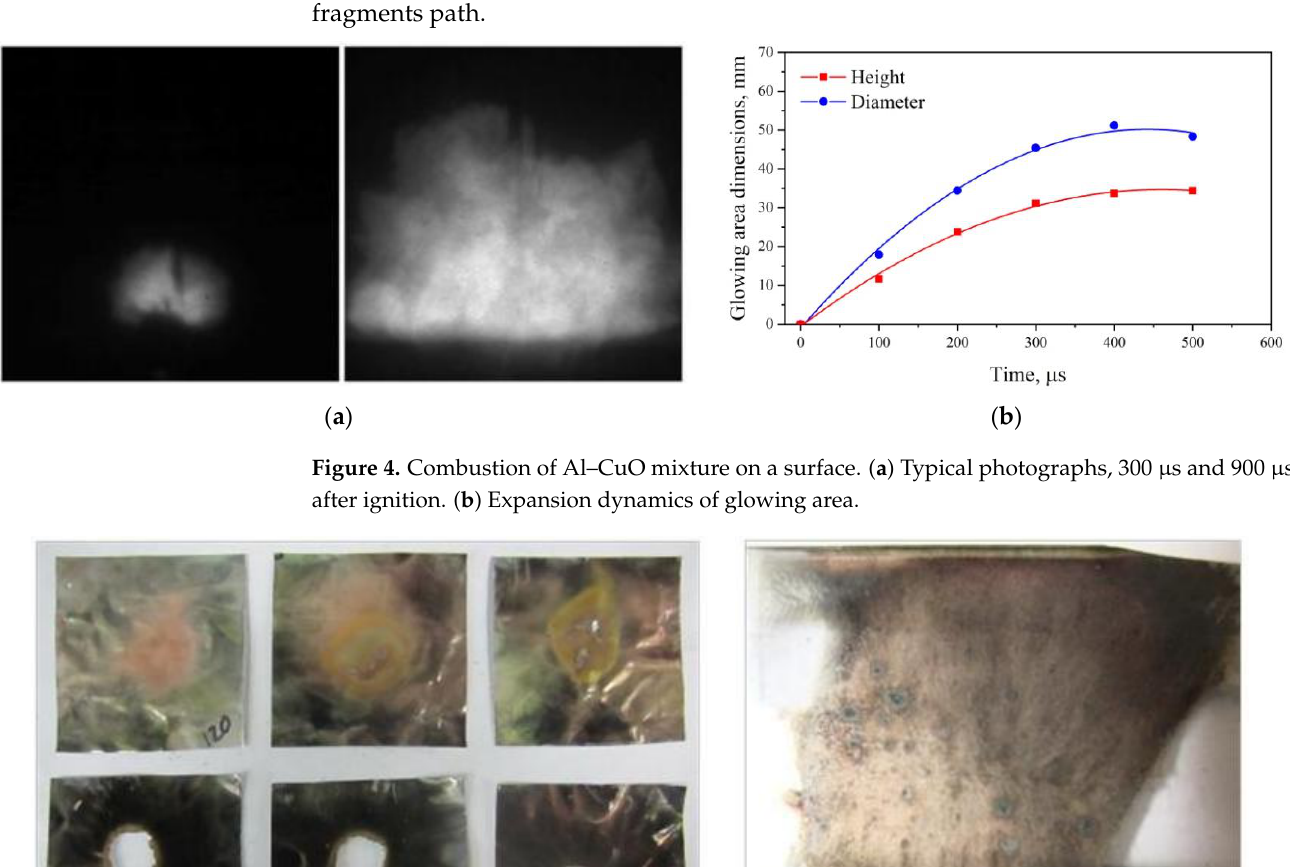
Figure 5. The photographic evidence of an impact of the frontal flow of combustion products. ( a ) The impact of mixture weighing 0.3 g on a 0.15 mm thick aluminium foil for distances of 120, 90, 60, 52, 45 and 30 mm (from left to right and from top to bottom), respectively. ( b ) Spots of interaction of the flow of reacting particles on a 0.3 mm thick polycarbonate target film. Photographic recording was not carried out in these experiments.